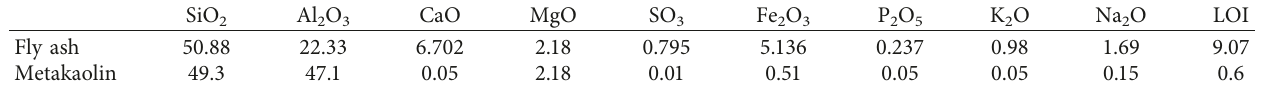
Table 1: Chemical composition of the pozzolanic materials.